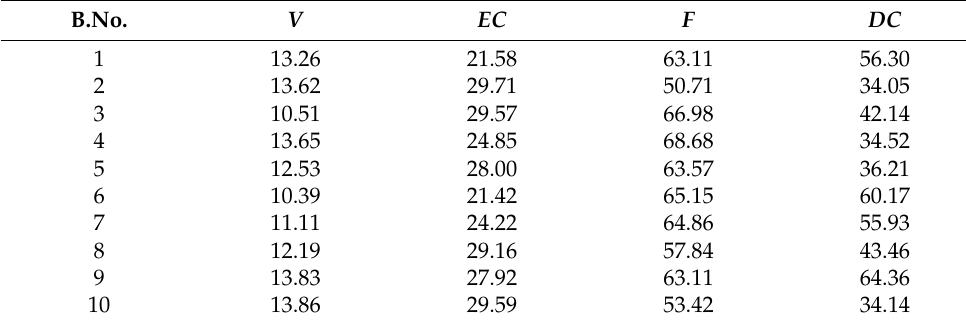
Table A1. Initialization of artificial bees. B.No.